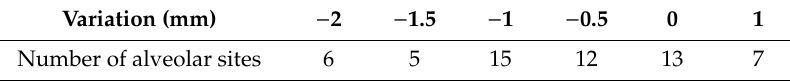
Table 5. Change in alveolar sites heights three months after extraction.